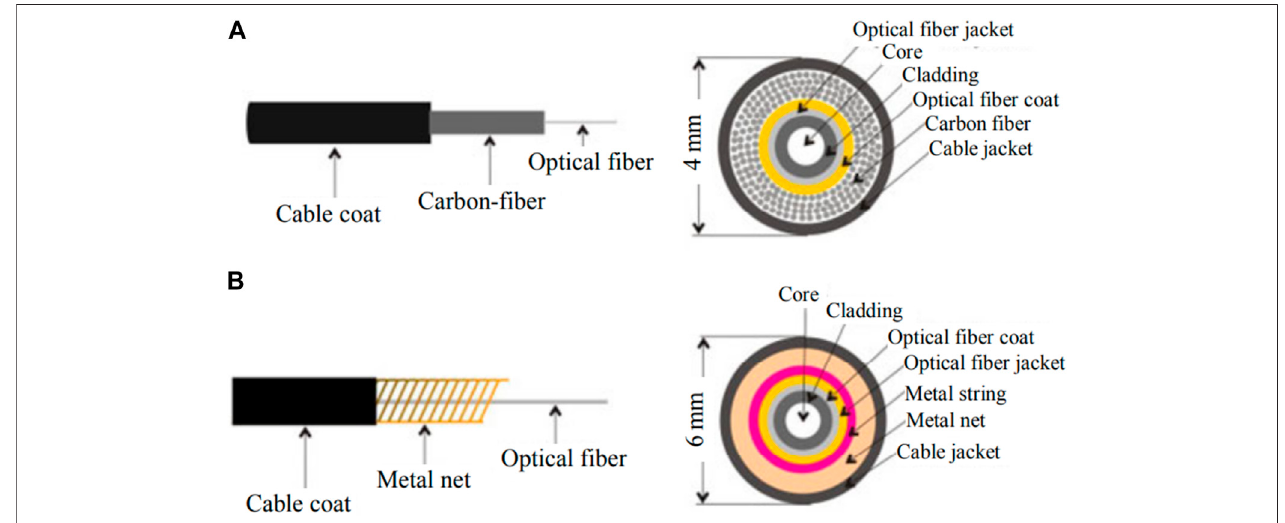
TABLE 1 | Comparison of physical properties between CFHC and MNHC.